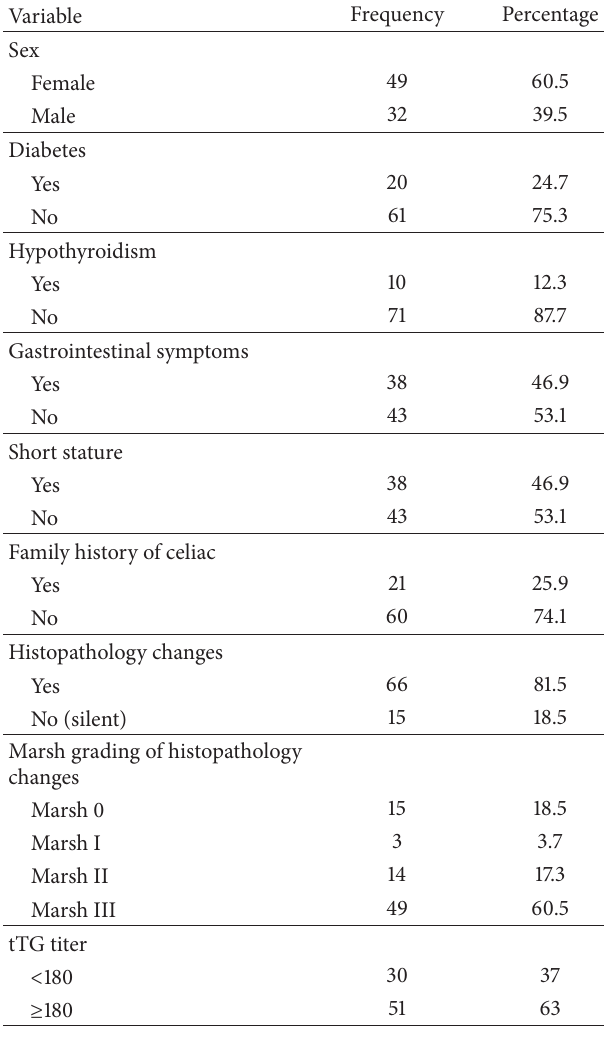
Table 1: Demographic and clinical characteristics of patients.